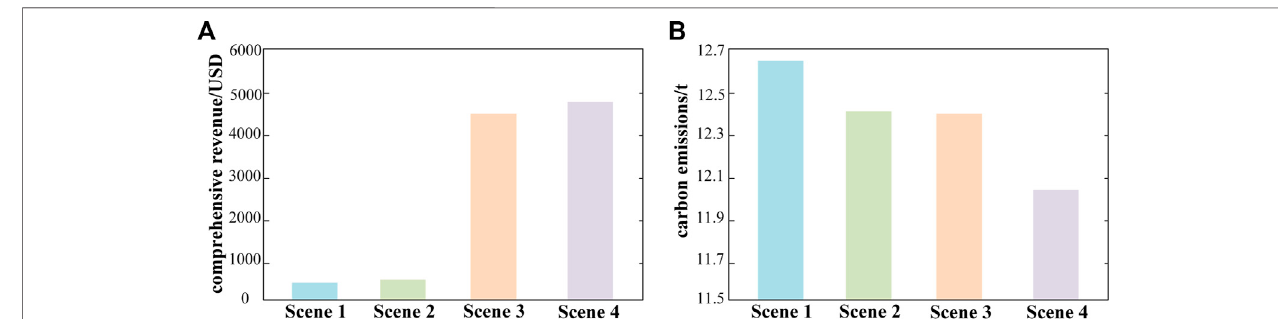
FIGURE 8 | Comparison results.